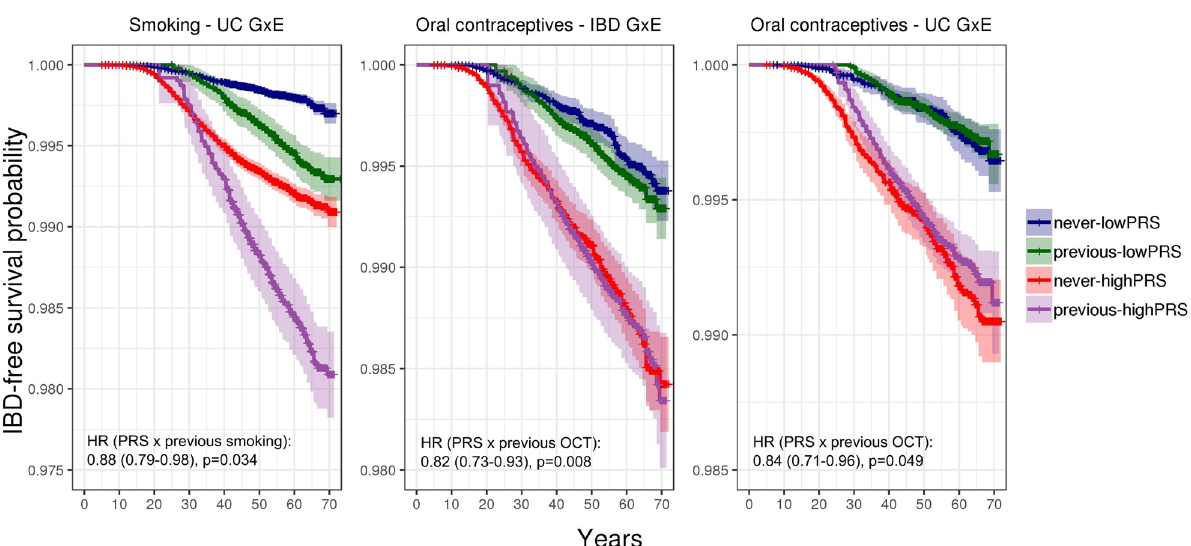
Figure 7. Kaplan–Meier curves for variables with statistically significant PRSxE interactions (FDR < 0.05 in Cox regressions conditional on polygenic risk and other covariates), with IBD diagnosis as the event. “Never” indicates participants never exposed to variable, “previous” refers to participants who started and subsequently stopped exposure, “lowPRS” refers to polygenic risk below median, “highPRS” refers to polygenic risk above median. Curves of current users are omitted to emphasize the interactive effect. OCT = oral contraceptive